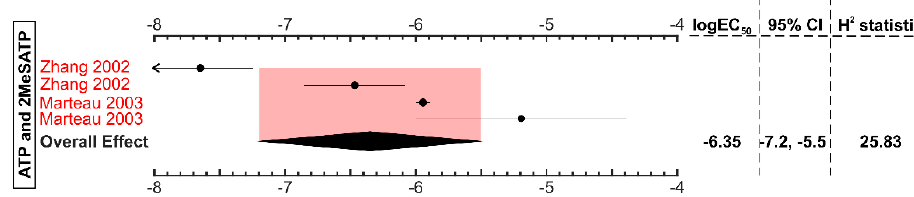
Figure 6. P2Y13-mediated signaling outcomes with ATP and ATP-like agonists. The forest plot contains the log 10 EC 50 values of ATP and 2MeSATP in generating P2Y13-mediated signaling outcomes. The black diamond represents the overall effect size, and the pink shaded region represents the 95% confidence interval. The study names marked in “red” were conducted in the heterologously-expressed P2Y13 receptor. All the studies were of sample size, n = 3, unless otherwise stated in parentheses.